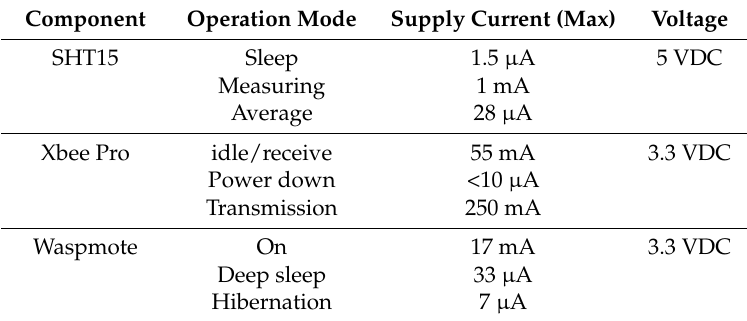
Table 1. Power consumption according to manufacturer’s data.